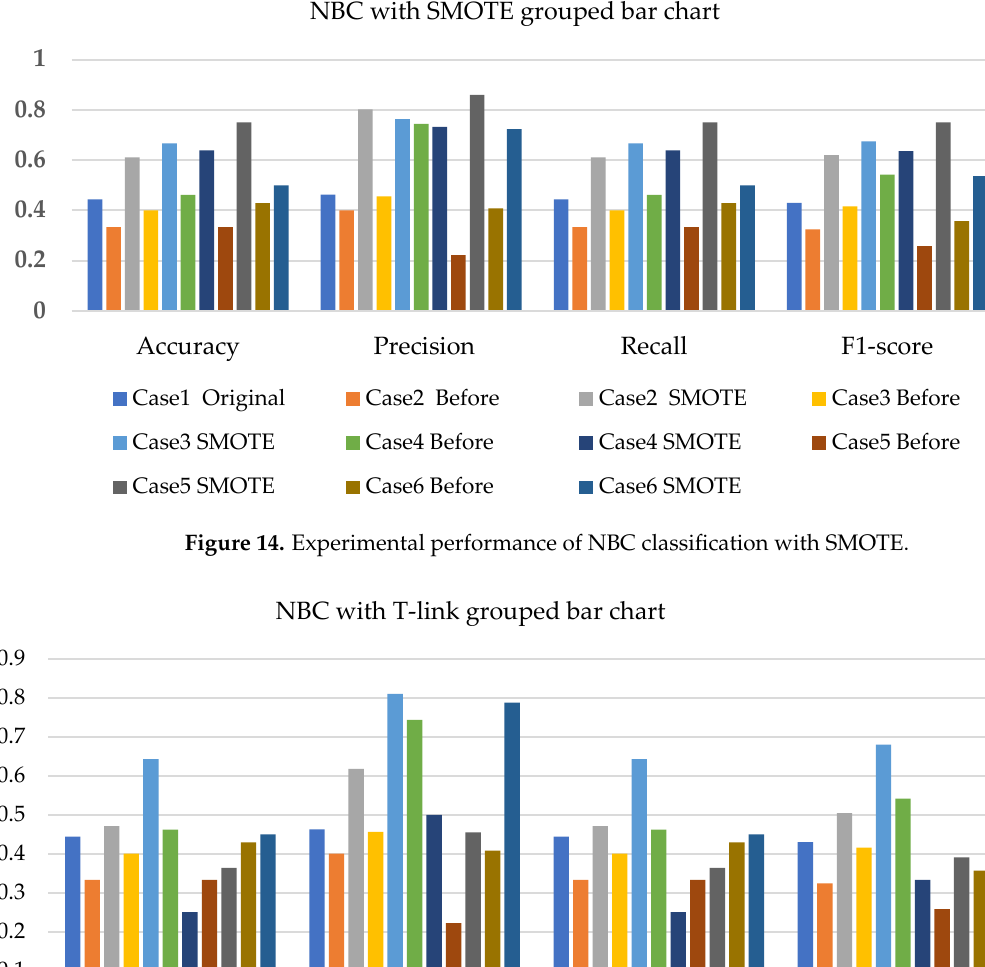
Figure 16. Experimental performance of NBC classification with SMOTE/T-link. Figures 17–19 present the weighted average performances of SVM with SMOTE, SVM with T-link, and SVM with SMOTE/T-link. The SVM with SMOTE presents case 2 having the highest performance of 0.5—accuracy and recall; 0.707—precision; and 0.506— F1-score. All other cases present slight improvements. The SVM with SMOTE has a mini- mum of 45% and a maximum of 56% accuracy. The SVM with T-link shows most of the cases with slight improvements, except case 6, which presents a performance with 16% lower accuracy and recall and a 13.4% lower F1-score than the performance of SVM with- out T-link. The SVM with T-link has a minimum accuracy of 40% and a maximum of 57%. The SVM with combined SMOTE / T-link presents each case with slight improvements.